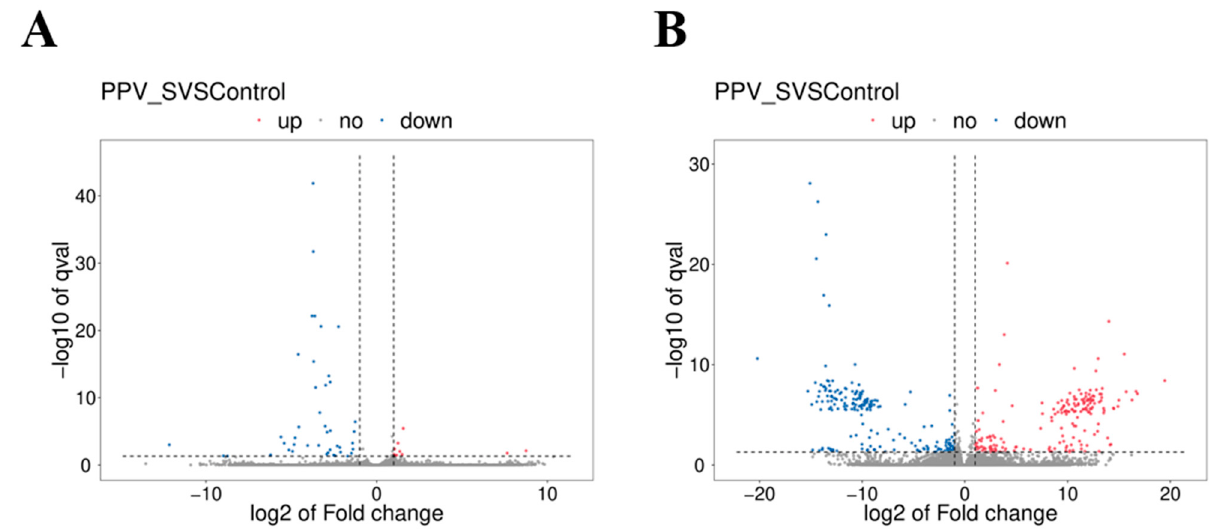
Figure 4. Volcano plot of the differential expression of mRNAs and lncRNAs in mouse spleens be- tween the control group and treatment group. ( A ) Differential expression of mRNAs. The blue points denote significantly downregulated mRNAs, while the red points denote significantly upregulated mRNAs. ( B ) Differential expression of lncRNAs. The blue points denote significantly downregulated lncRNAs, while the red points denote significantly upregulated lncRNAs.